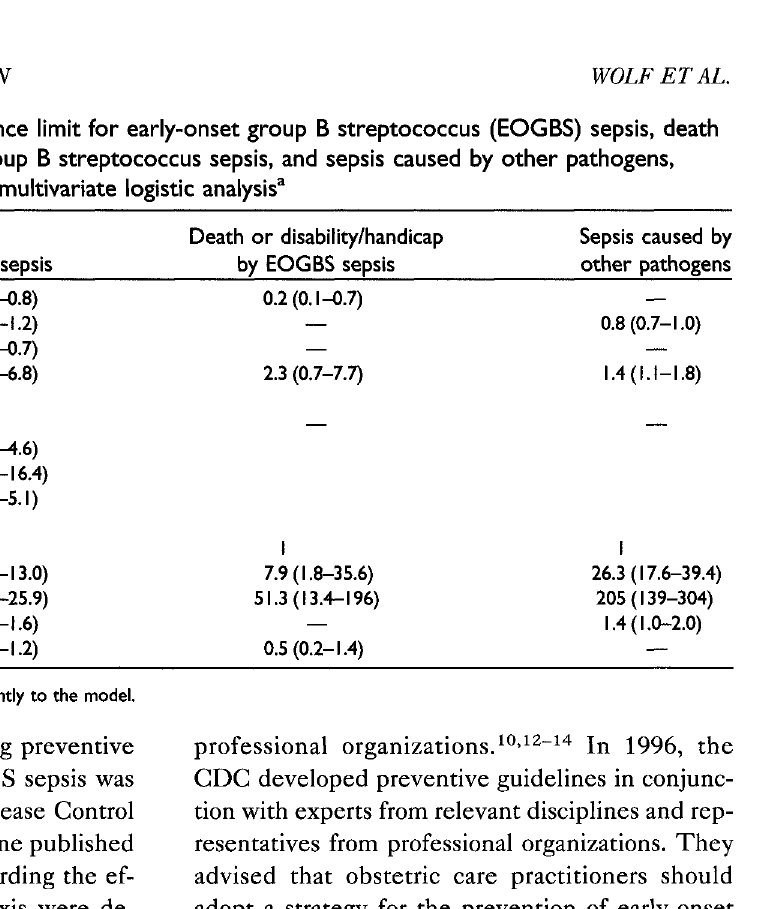
TABLE 5. Odds ratio with 95% confidence limit for early-onset group B streptococcus (EOGBS) sepsis, death or disability/handicap by early-onset group B streptococcus sepsis, and sepsis caused by other pathogens, calculated by the final step of stepwise multivariate logistic analysis Death or disability/handicap Sepsis caused by EOGBS sepsis by EOGBS sepsis other